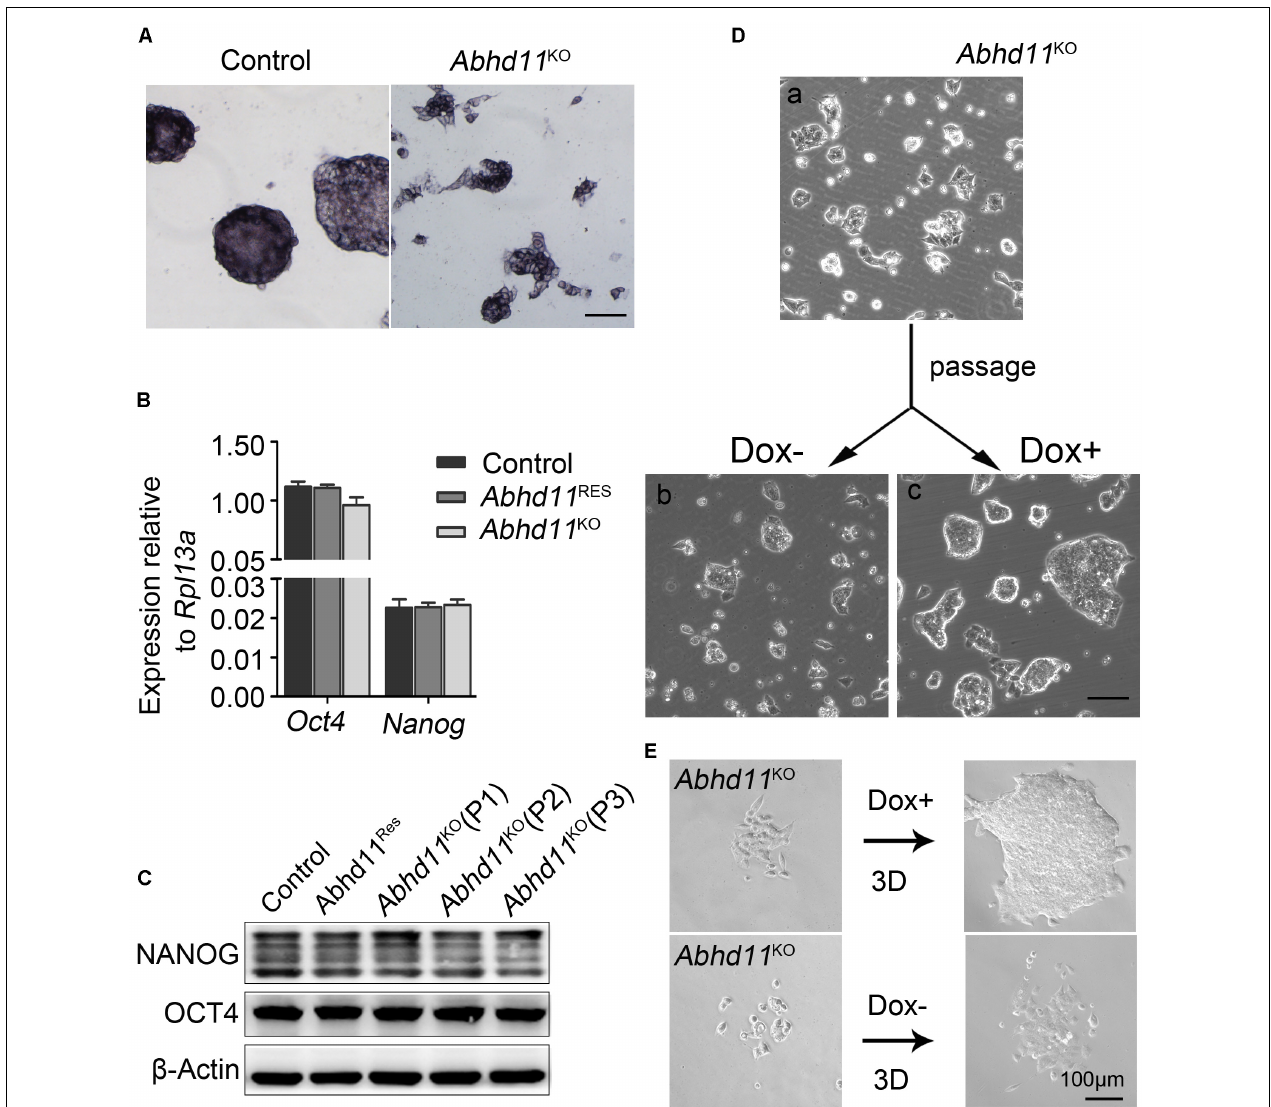
FIGURE 4 | Abhd11 is dispensable for the maintenance of pluripotency. (A) Alkaline phosphatase staining of colonies formed by the indicated cells. Scale bar, 100 µ m. (B) qRT-PCR analysis of Oct4 and Nanog mRNA level in the indicated cells. (C) Western blot analysis of OCT4 and NANOG expression level in the indicated cells during passage. (D) Representative morphology of colonies formed by Abhd11 KO ESCs at high colony density. (E) Morphologies of colonies formed by Abhd11 KO ESCs at low colony density.